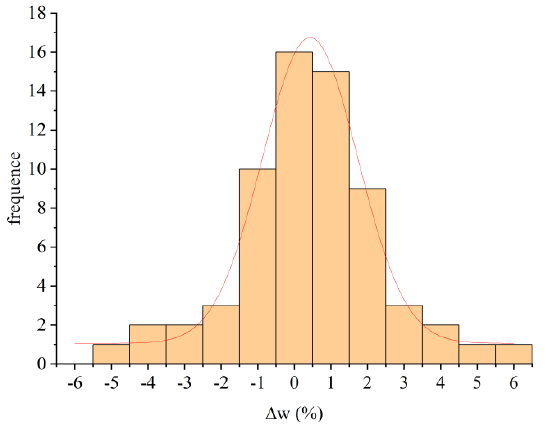
Figure 7. Statistical result chart of the relative error frequency of density of M1.